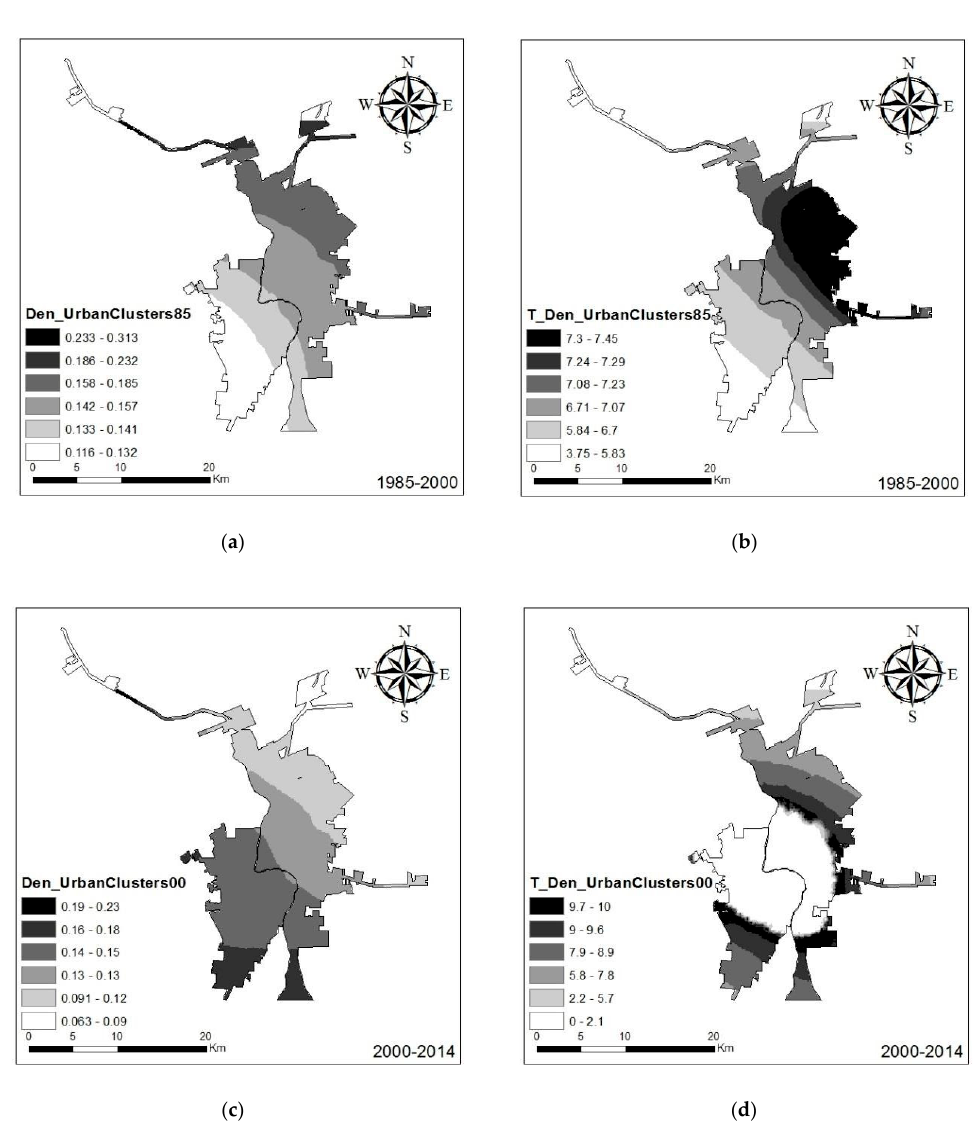
Figure 9. Logistic GWR results of the estimated coefficient ( a , c ) and T-statistic surfaces: density of existing urban clusters ( b , d ), 1985–2000 and 2000–2014.